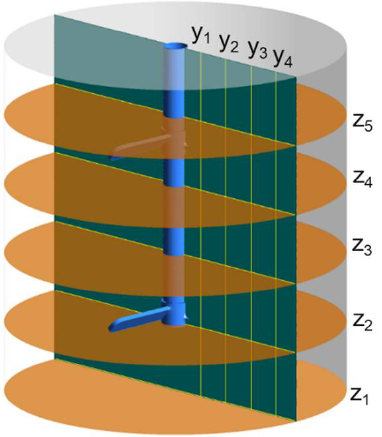
Figure 3. Distribution of the monitoring position in the vessel.